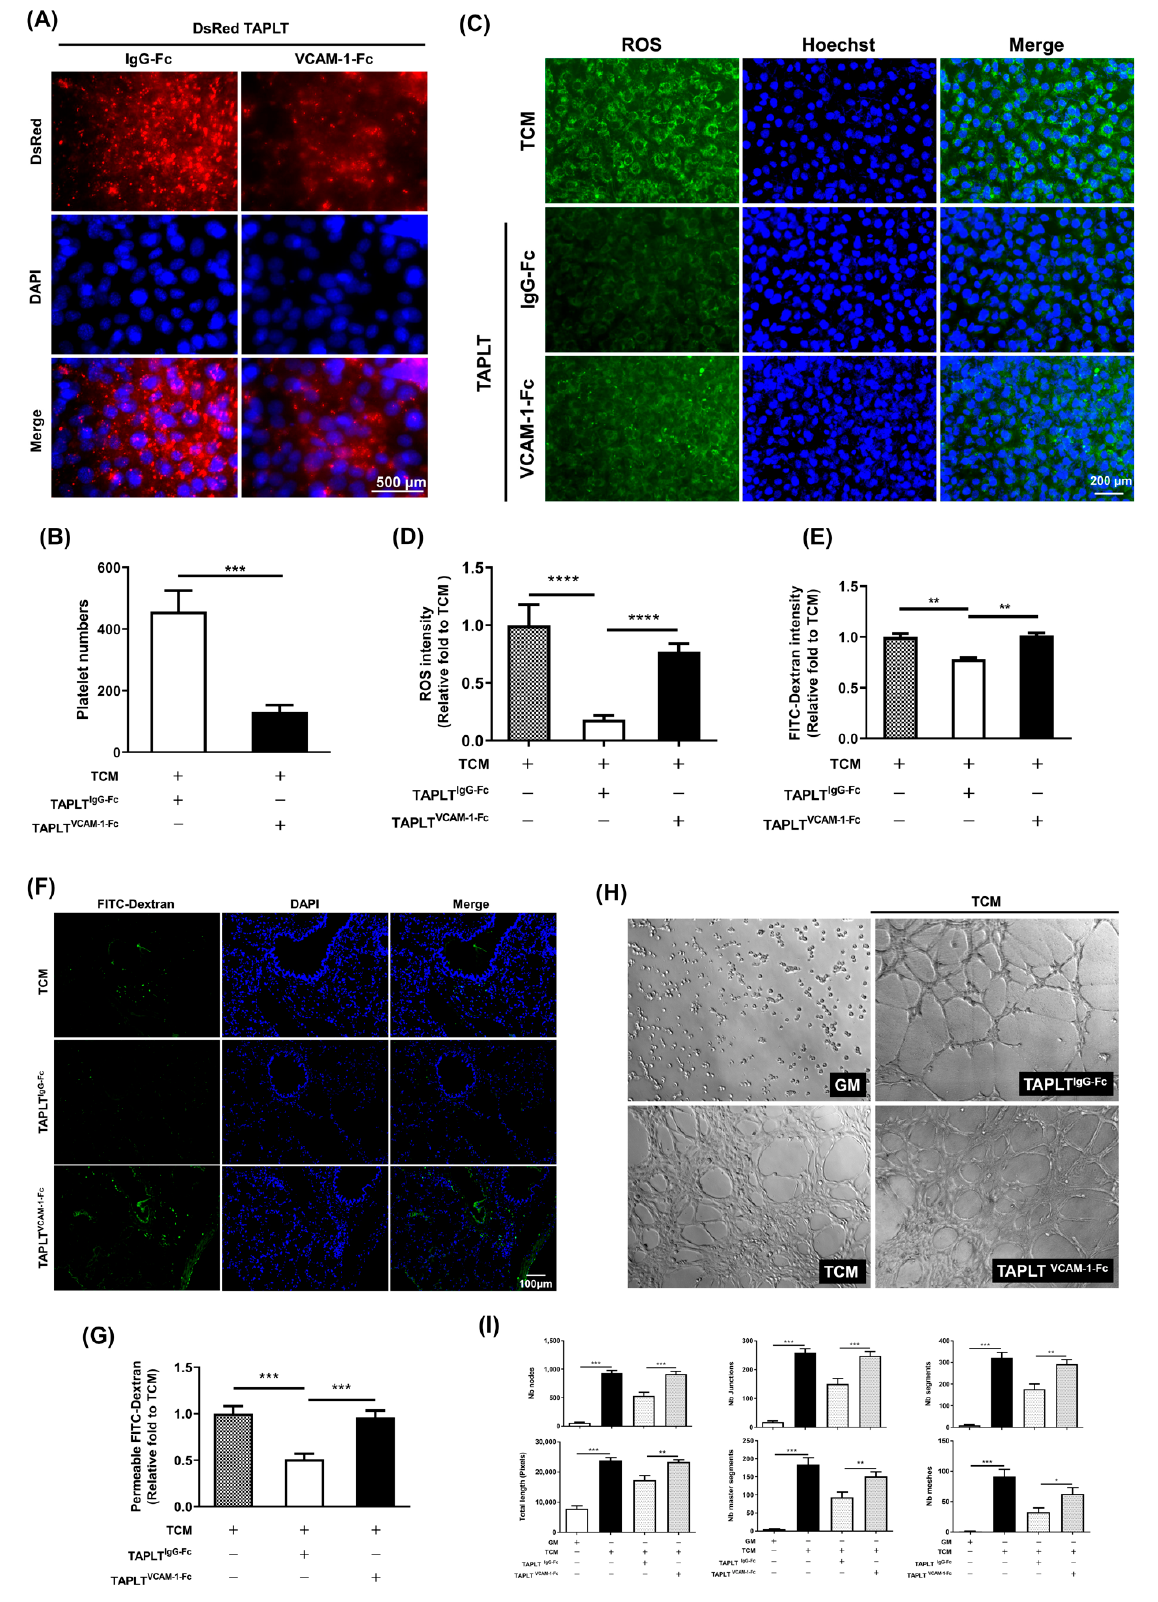
Figure 7. Neutralization of VCAM-1 binding abrogates TAPLT protection against